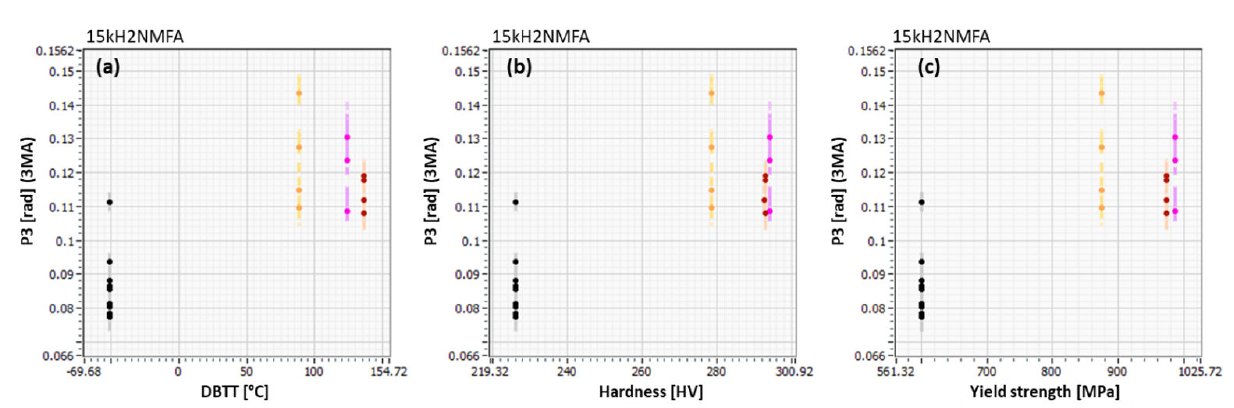
Figure 15. Dependency of the amplitude of third harmonics P3 on DBTT ( a ), hardness ( b ), and yield strength ( c ) of eastern RPV material 15Kh2NMFA.